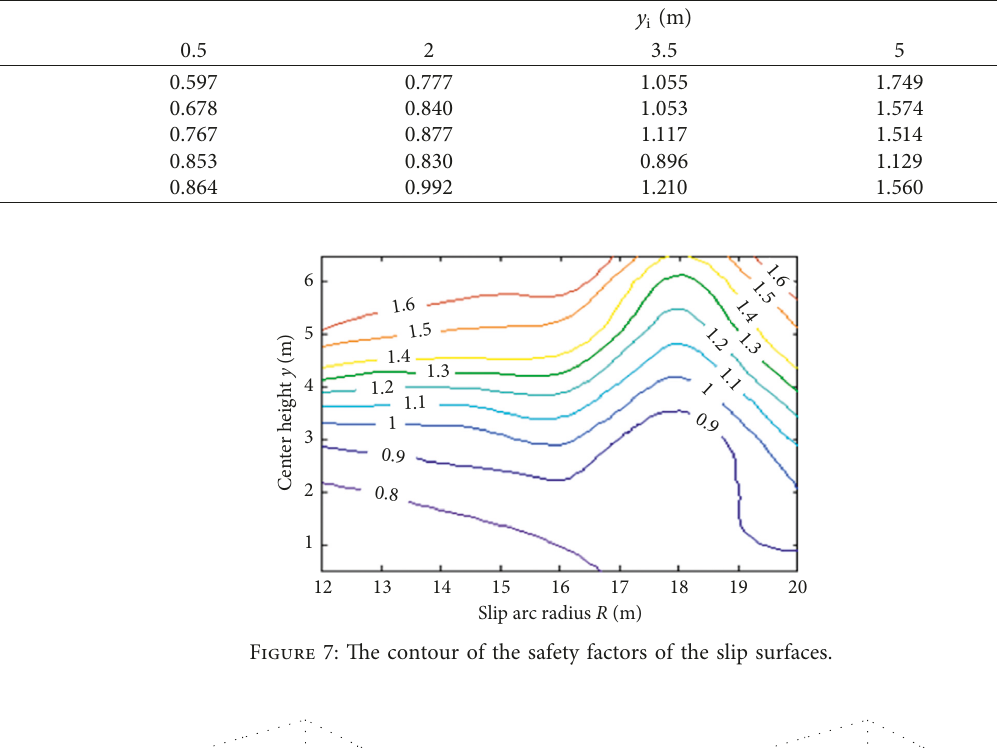
Table 3: The calculation results of safety factors of 25 slip surfaces.